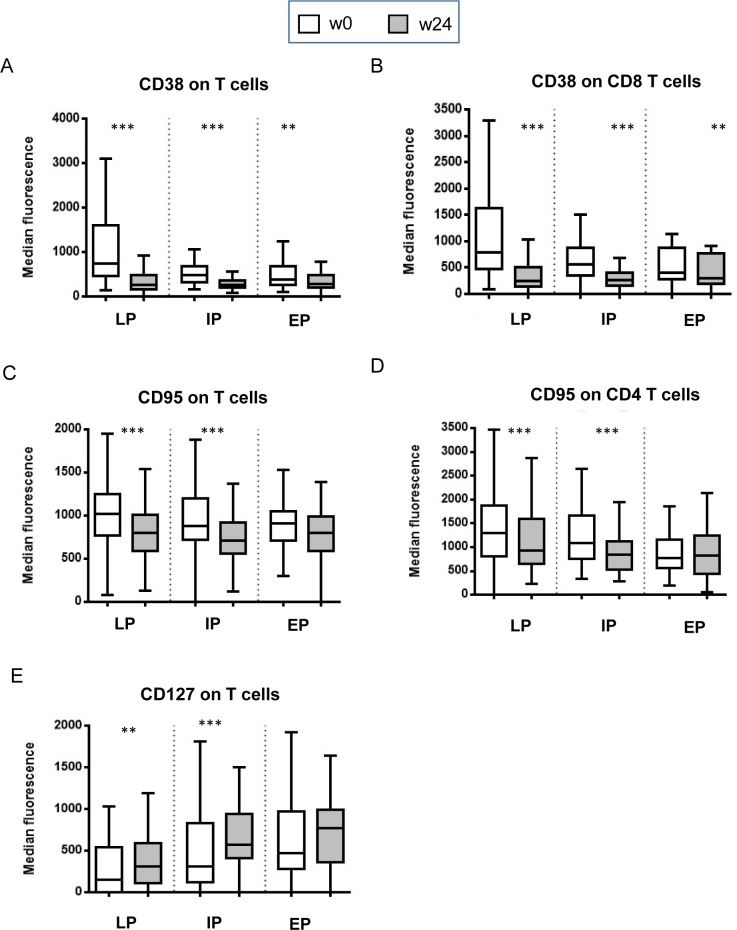
Impact of cART on T cell activation markers.The activation and early marker expression was evaluated by flow cytometry before (wo, white bars) and after (w24, grey bars) therapy. The expression of CD38 was evaluated on T cells (A) and on CD8 T cells (B). The expression of CD95 was evaluated on T cells (C) and on CD4 T cells (D). The expression of CD127 was evaluated on T cells (E). Results are shown as median of fluorescence intensity (MFI) using Box and Whiskers graphs. The parametric Wilcoxon test was used and p<0.05 was considered significant. **: p<0.01; ***: p<0.001.